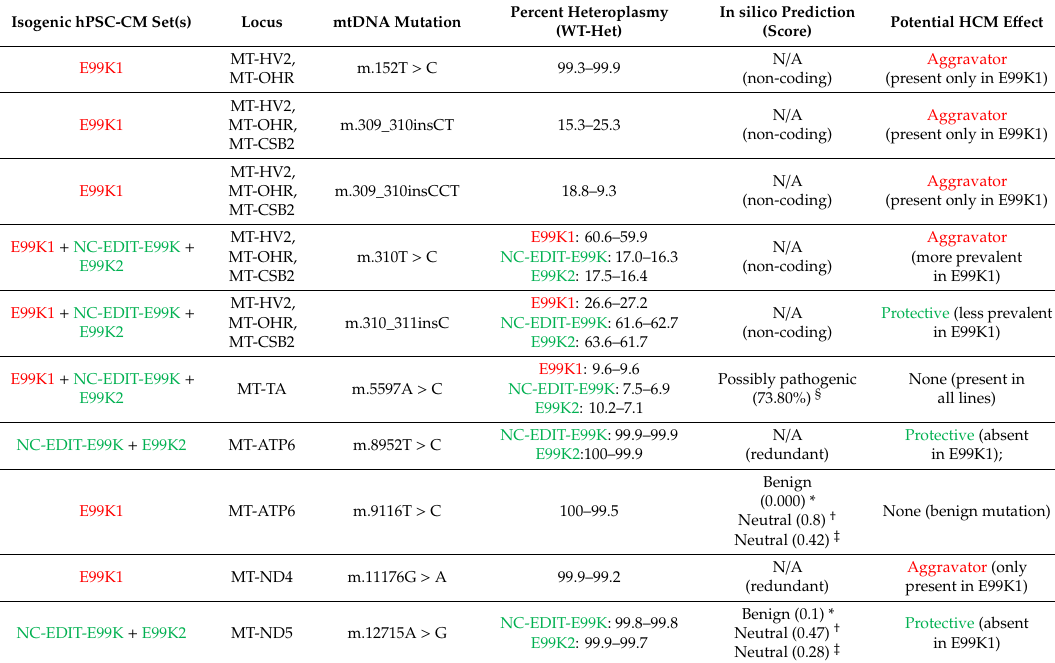
Table 2. mtDNA variants identified by NGS in p.E99K-ACTC1 isogenic lines used for HCM modeling (WT, healthy; het, heterozygous). In silico pathogenicity prediction algorithms used: § MitoTIP; * Polyphen-2; † CAROL; ‡ APOGEE. Phenotypically severe hPSC-CM line is highlighted in red and less severe ones in